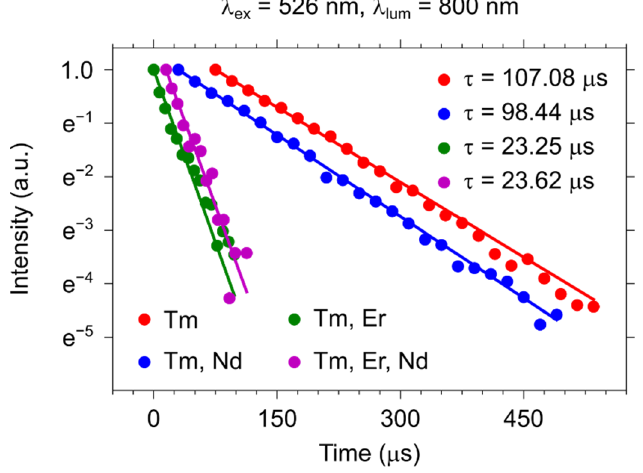
Figure 7. Luminescence decay curves of one-, two-, and triple-doped samples with the selective excitation of Tm 3+ ions.